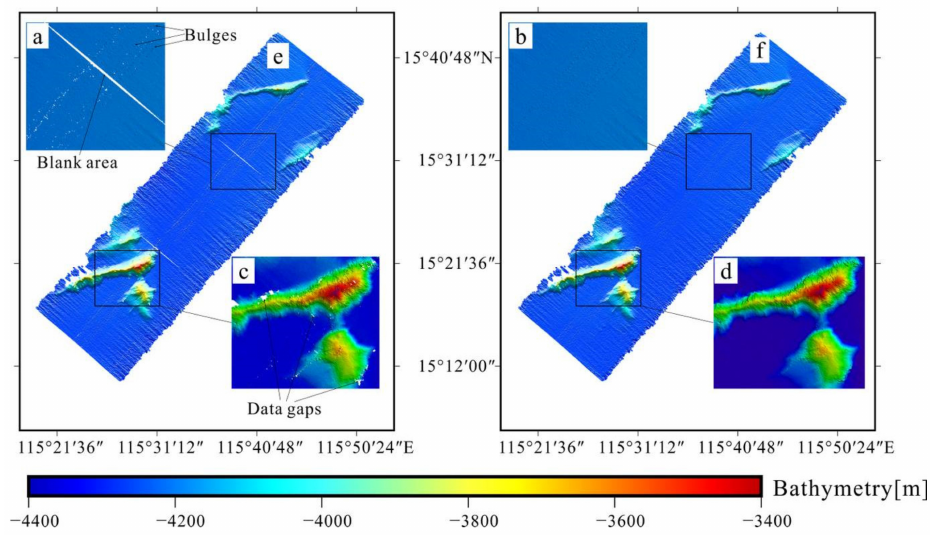
Figure 4. Anomaly correction and data interpolation of the multi-beam bathymetry data. ( a ) Anoma- lies in the central beam area. The anomalies include abnormal bulges and data gaps. ( b ) The processed result after the filtering and interpolation of ( a ). ( c ) The raw bathymetry data for seamounts. ( d ) The processed bathymetry data of the seamounts. The abnormal bulges at the top of the seamounts were eliminated, and the data gaps around the seamounts were filled. ( e ) Anomalies in the edge-beam area. ( f ) The processed results of ( e ). The “wavy anomaly” was removed and the data gaps were